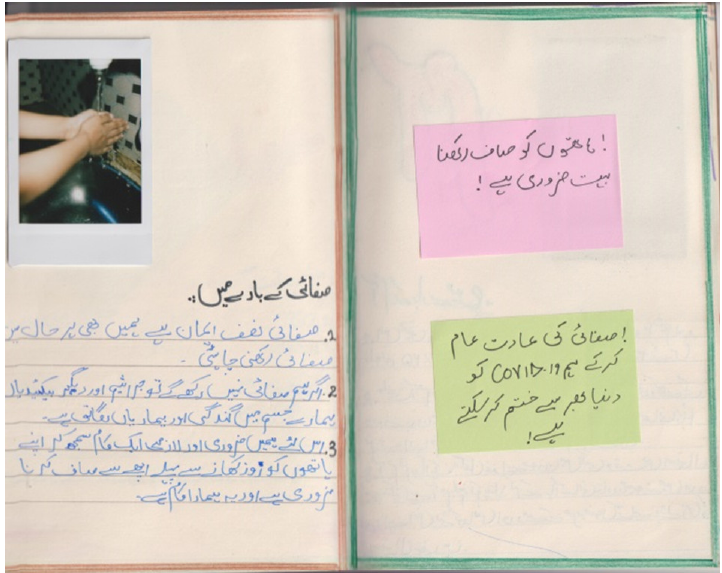
Figure 6. Sulman’s photodiary: Keeping hands clean is very necessary. We can eliminate COVID-19 by making the habit of cleaning part of our daily routine. Cleanliness is half the faith, we should stay clean at all costs. If we don’t keep things clean then these germs and bacteria will affect our bodies and make us ill. That’s why we should consider it important and essential task to wash our hands before eating anything and this is our responsibility.